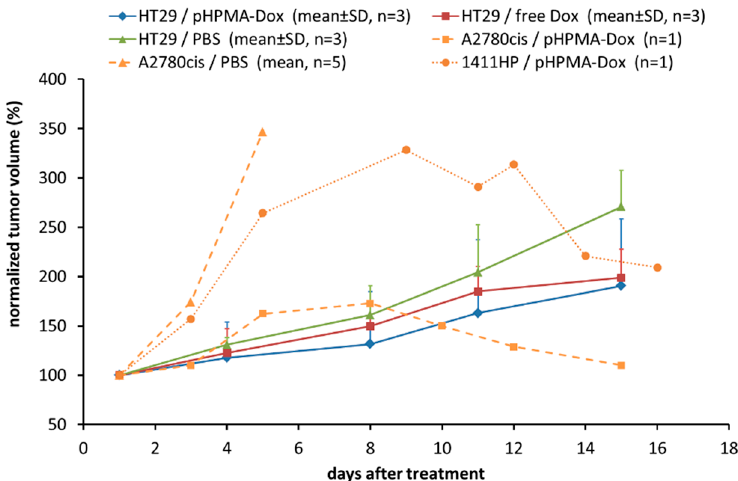
Figure 1. Tumor growth and treatment response pattern of HT29 tumors compared to 1411HP and A2780cis tumors. Mice were treated on days 1 and 4 with PBS or free Dox (5 mg/kg) or a 2-fold Dox equivalent dose of pHPMA-Dox. Depicted are the tumor volumes normalized to day 1 (start of treatment). The three graphs displaying 1411HP and A2780cis tumors are data of our previous study [13] and were reused here for comparison of the tumor models. The PBS graph of A2780cis is